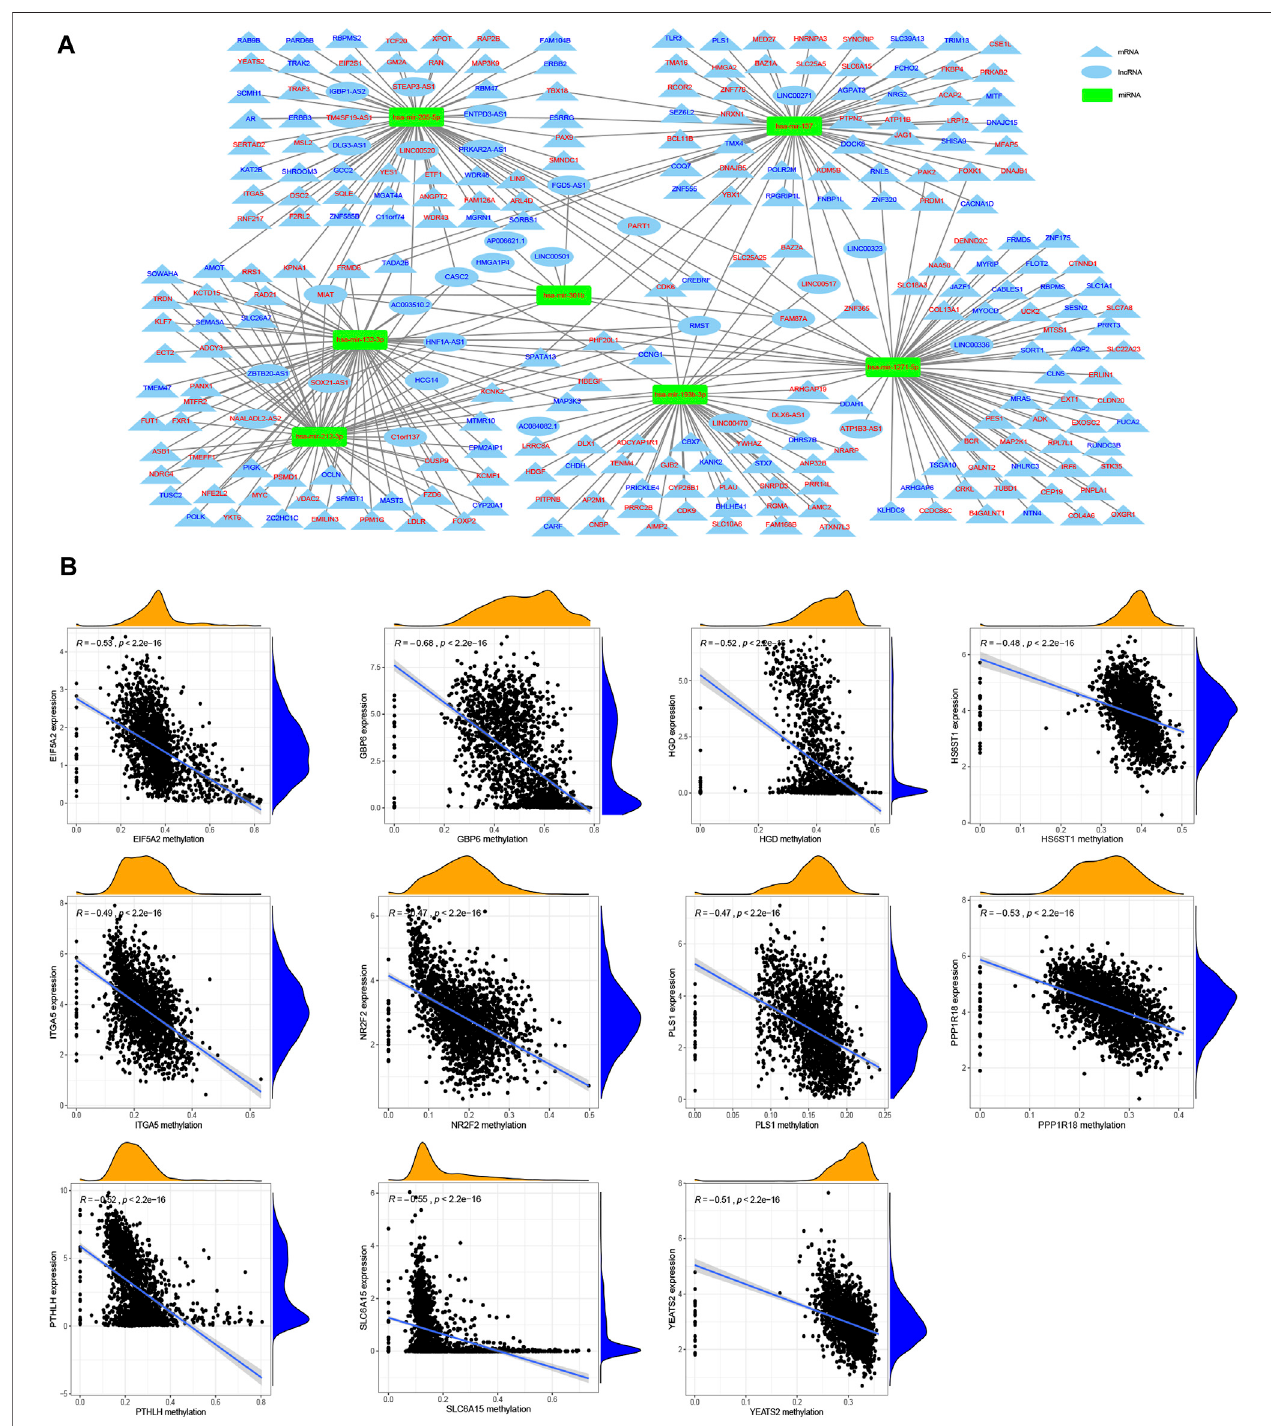
FIGURE 9 | Construction of ceRNA network and identi fi cation of methylation driver genes. (A) CeRNA network shows the associations between the targeted lncRNAs (oval) and mRNAs (triangle) of miRNAs (rectangular) related to the tumor pathogenesis of smoking, in which red denotes up-regulation while blue indicates down-regulation. (B) Correlation analysis of gene expression and its methylation level.